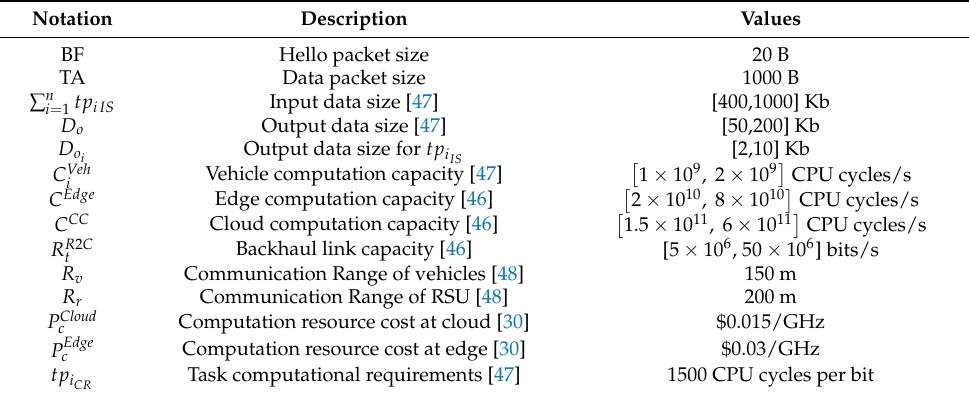
Table 2. Parameter